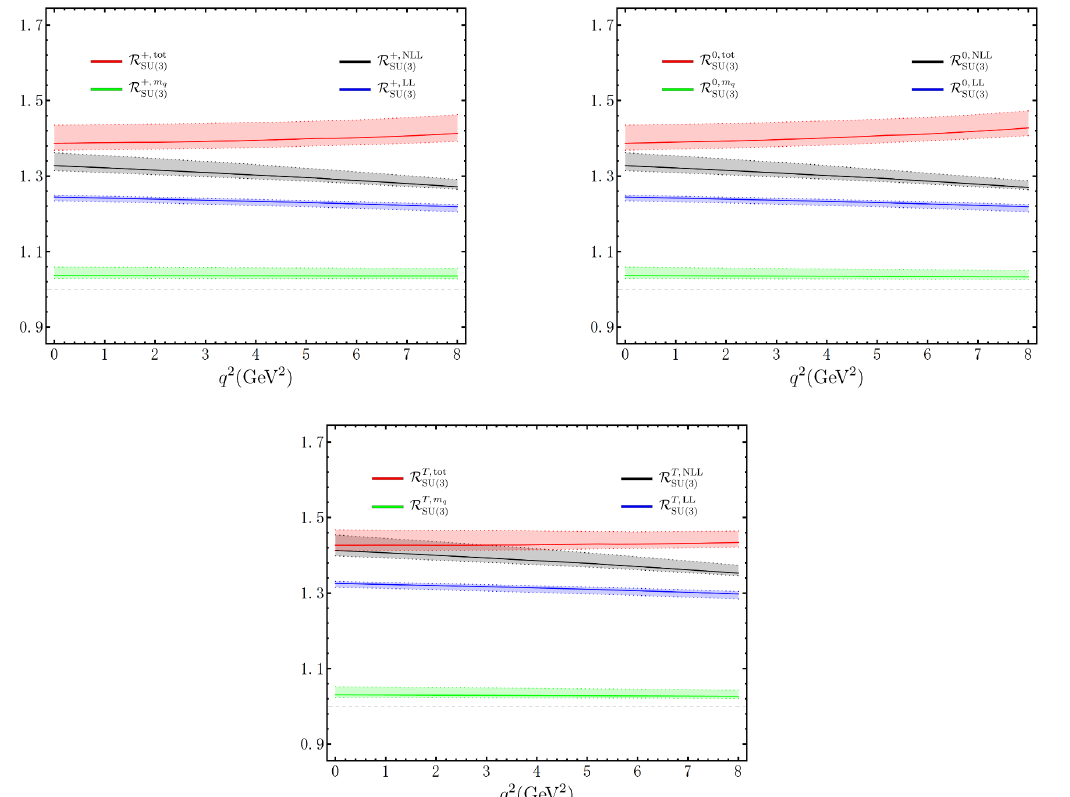
Figure 5 . Theory predictions for the SU(3)-flavour symmetry breaking effects between the semilep- tonic B → π and B → K form factors from the updated SCET sum rules with the bottom-meson distribution amplitudes at the twist-six accuracy, where the perturbative uncertainties due to the variations of both the hard and hard-collinear matching scales are indicated by the individual error bands. We further present the resulting SU(3)-flavour symmetry violation effects R i,m q (with i = + , 0 , T ) merely from the light-quark mass corrections at the leading-power accuracy (green